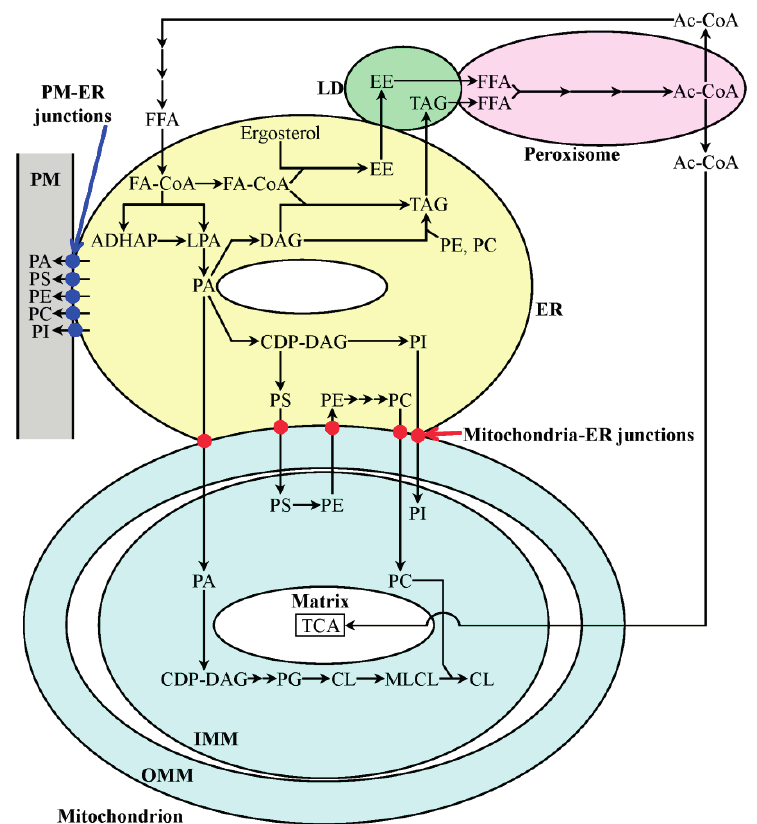
Figure 1. Outline of a network governing lipid metabolism and transport within the endoplasmic reticulum (ER), lipid droplets (LD), peroxisomes, mitochondria and the plasma membrane (PM). The proper functioning of this intricate network is necessary for maintaining lipid homeostasis in all of these cellular organelles and membranes. The PA, PS, PC and PI classes of phospholipids are synthesized exclusively in the ER; these are then transported to mitochondria via mitochondria-ER junctions and to the PM via PM-ER junctions. The PE and CL classes of phospholipids are formed only in the inner mitochondrial membrane (IMM); PE is then transported from mitochondria to the ER via mitochondria-ER junctions and from the ER to the PM via PM-ER junctions. The neutral lipids TAG and EE are synthesized in the ER and then deposited within LD. The lipolytic hydrolysis of TAG and EE in LD generates FFA; these then get imported and oxidized by peroxisomes. Peroxisomally produced acetyl-CoA is converted to citrate and acetyl-carnitine, whose subsequent delivery to mitochondria enables one to maintain the efficient synthesis of PE and CL in the IMM. The use of peroxisomally produced acetyl-CoA for the synthesis of FFA in the cytosol allows FFA to enter the biosynthetic pathways for phospholipids and neutral lipids in the ER. See the text for additional